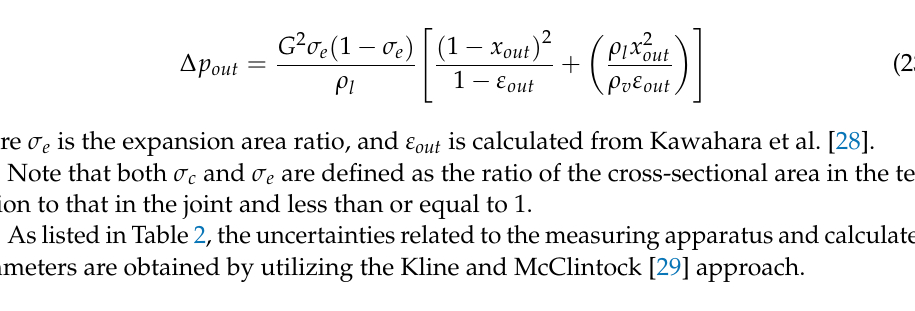
Table 2. Experimental uncertainties.